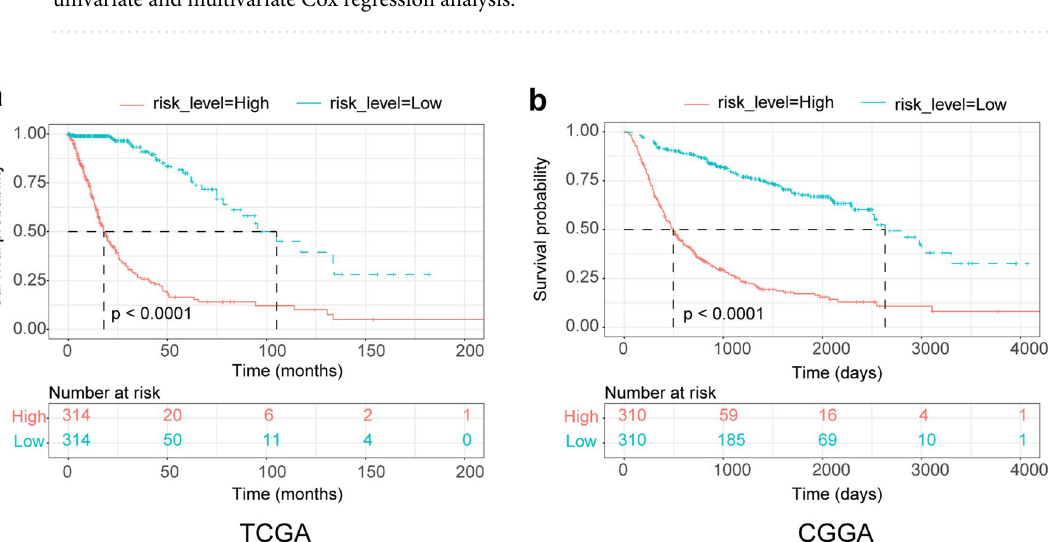
Table 1. Univariate and multivariate Cox regression in the TCGA and CGGA data sets. P value obtained by univariate and multivariate Cox regression analysis.